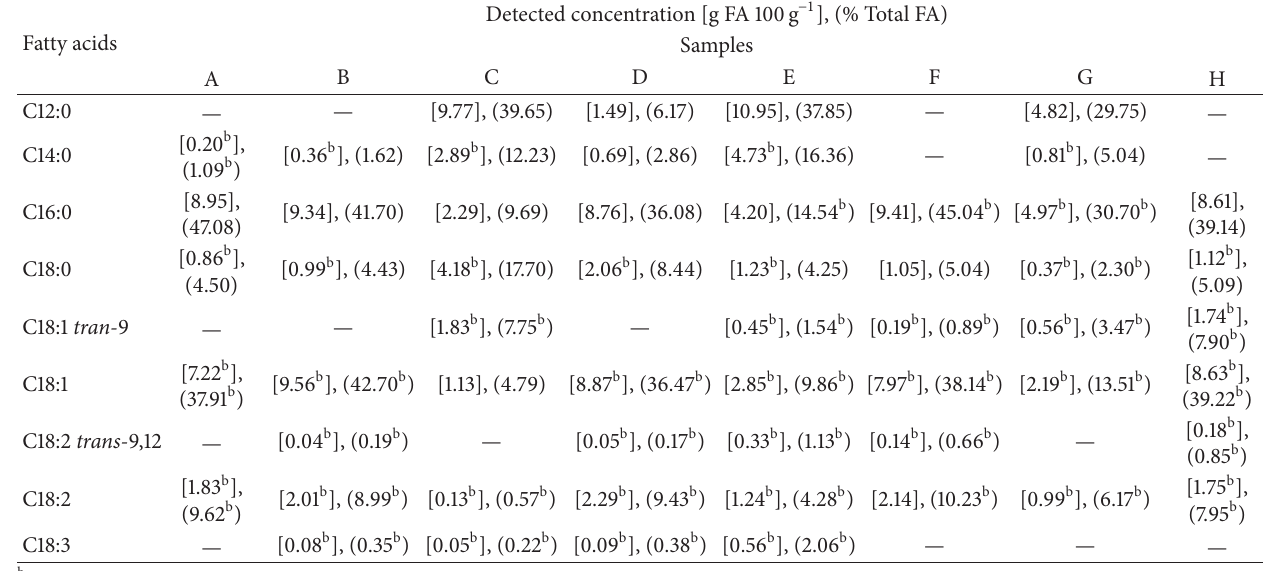
Table 2: The mean of the absolute (g FA 100 g −1 sample) and relative (% of total identified FA) content of each FA determined using the TMA-DM